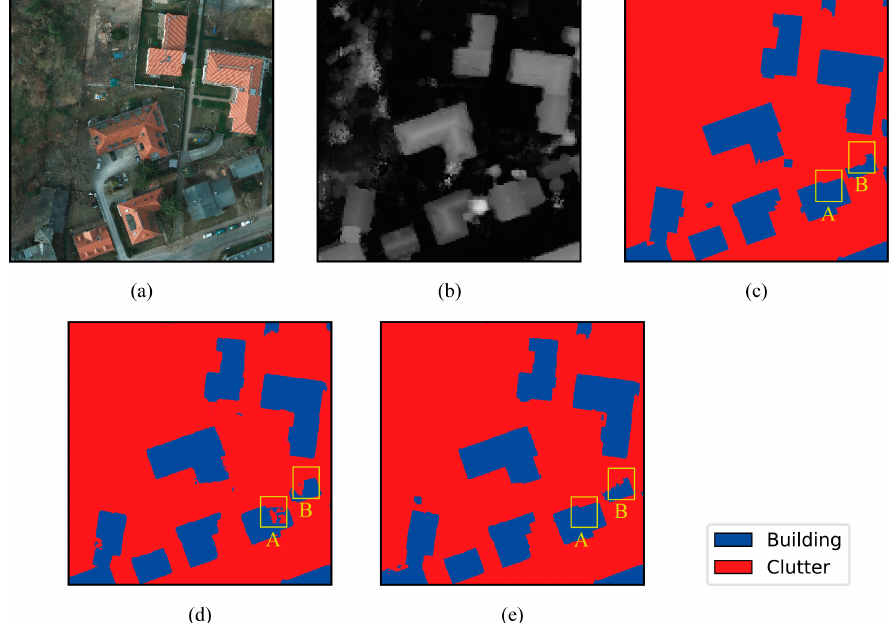
Figure 9. The results of the building extraction in the urban district of the Potsdam dataset with and without the DSM as a channel of the input. ( a ) The original imagery of the urban district. ( b ) The DSM of this district. ( c ) The ground of this region. ( d ) The prediction results using the Res-U-Net without the DSM as a channel of input. ( e ) The prediction results corresponding to the input with the DSM.